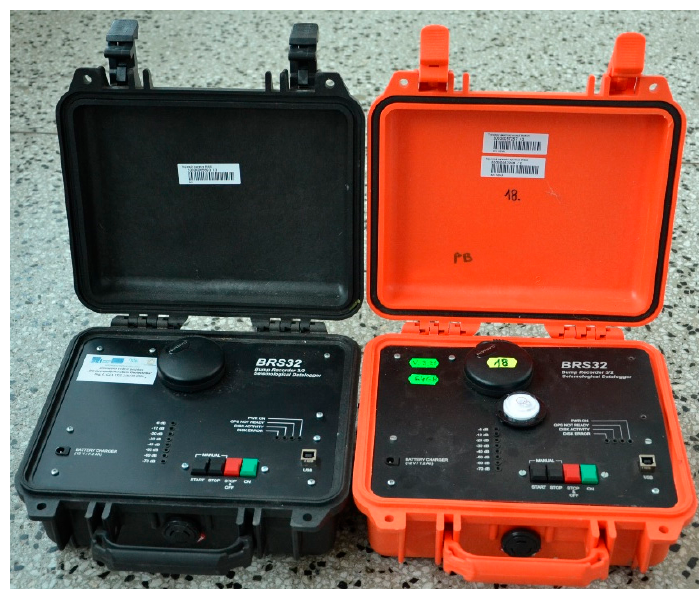
Figure 1. BRS32 seismic stations used as reference